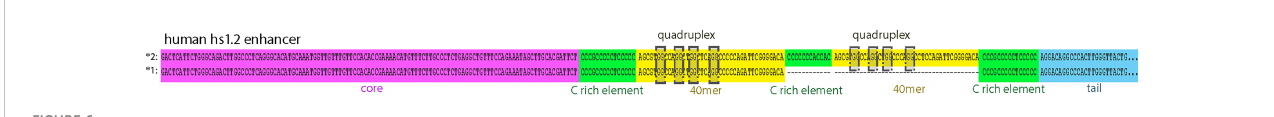
FIGURE 6 Sequence and notable regions of the hs1.2 enhancer. Allele *1 and *2 of the human hs1.2 enhancer are illustrated to highlight the presence of the internal 40 bp monomer (40mer), which has the potential to form quadruplex DNA (i.e. a stable secondary DNA structure). A “ core ” (magenta) and a “ tail ” (light blue) sequence are common to all the variants, while the “ 40mer ” repeat (yellow box) may be present from one to four times in